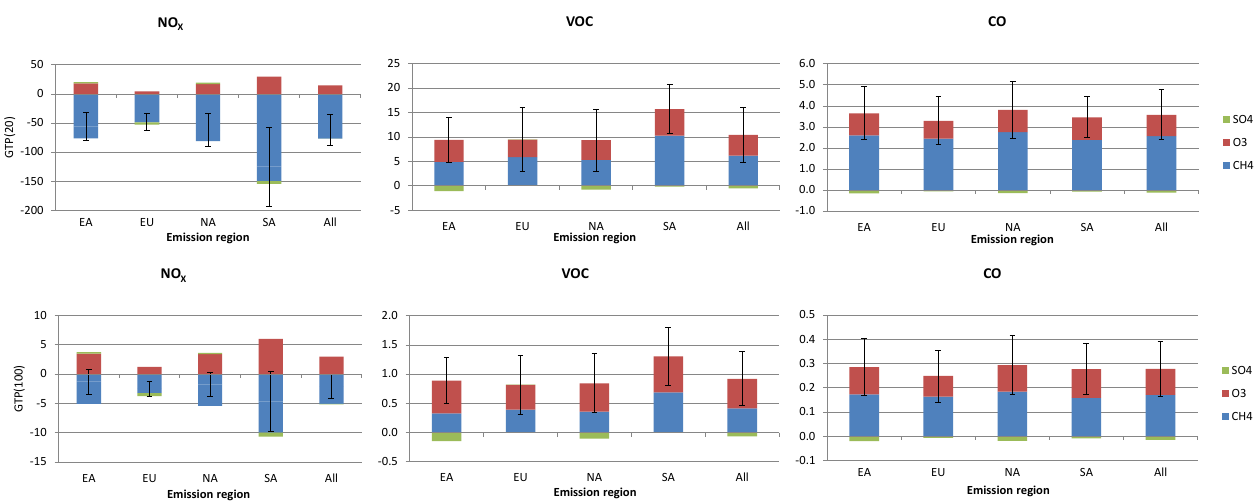
Fig. 4. GTP(20) and GTP(100) for emissions of NO x , VOC and CO from the four HTAP continents separately and combined (“All”). The GTPs are split according to the contributing components. For O 3 and SO 4 these combine both the short and long-term components. The contribution from stratospheric water vapour is included in with CH 4 . Error bars reflect 1 standard deviation uncertainty in the multi-model